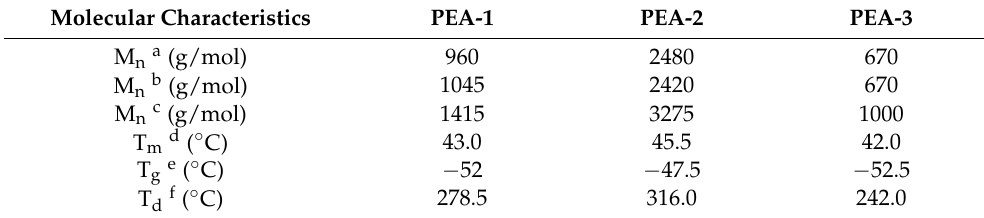
Table 2. Molecular characteristics of the obtained di-hydroxylated polyesters. Molecular Characteristics